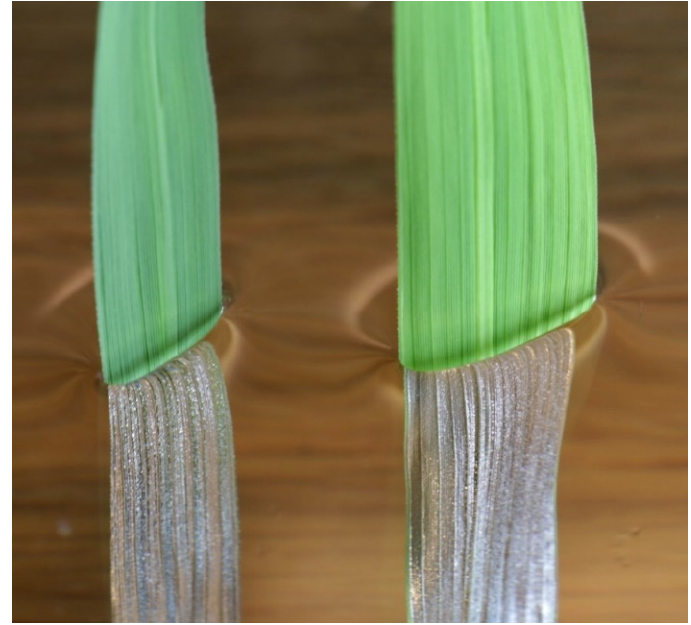
Figure 9. Rice ( Oryza longistaminata A. Chev. & Roehr.) leaves protrude through the water surface, covered below the water surface by a layer of air. Photo by Ole Pedersen, University of Copenhagen. Cf. the cover of Science Vol. 228, No. 4697, 19 April 1985.